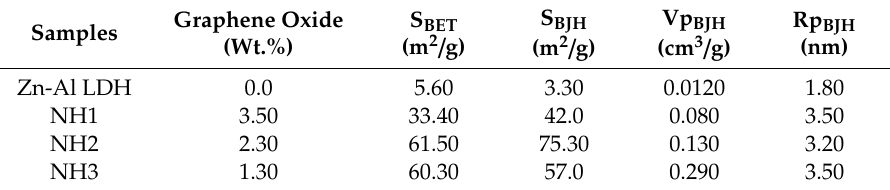
Rp BJH , Vp BJH and S BJH , pore radius, total pore volume and specific surface area calculated by the BJH method, respectively;